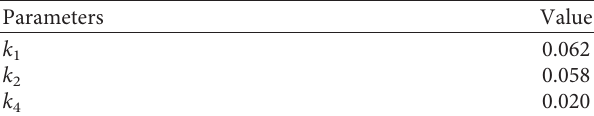
Table 3: Inversion of stress boundary parameters.